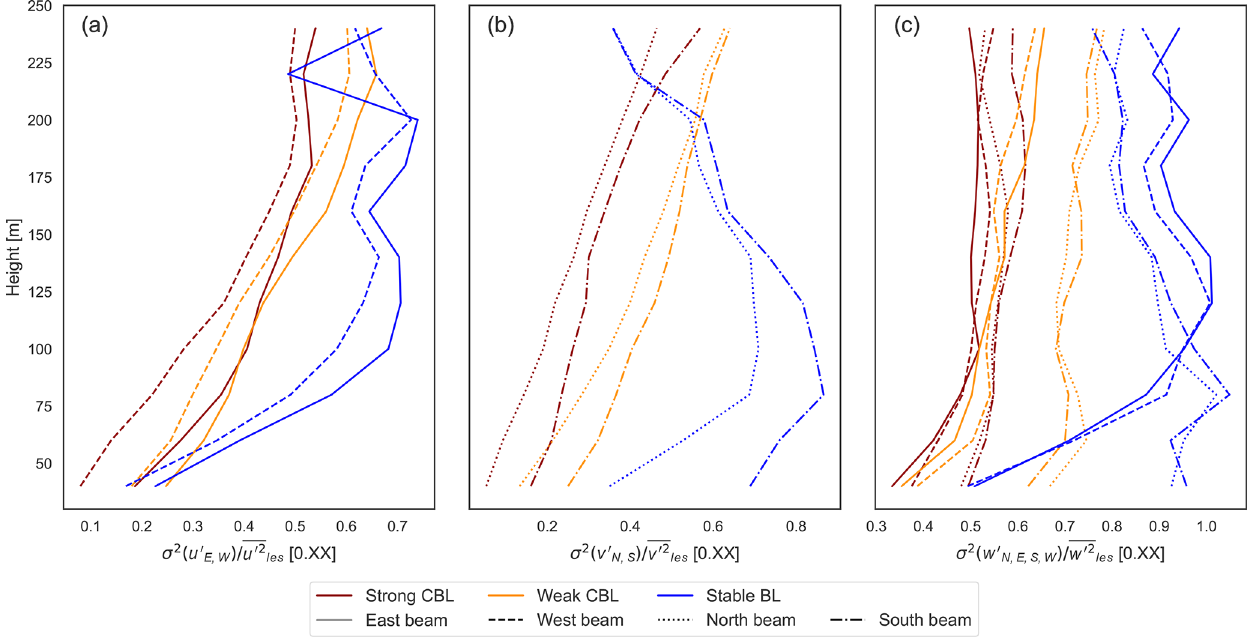
Figure 10. The proportion of the full turbulent velocity variances ( u (cid:48) 2 ,v (cid:48) 2 ,w (cid:48) 2 ) present in the variance of the turbulent perturbations from ) ). Ratios shown using the perturbation variances at each the lidar scan-volume average (e.g. σ 2 (u (cid:48)(cid:48) E